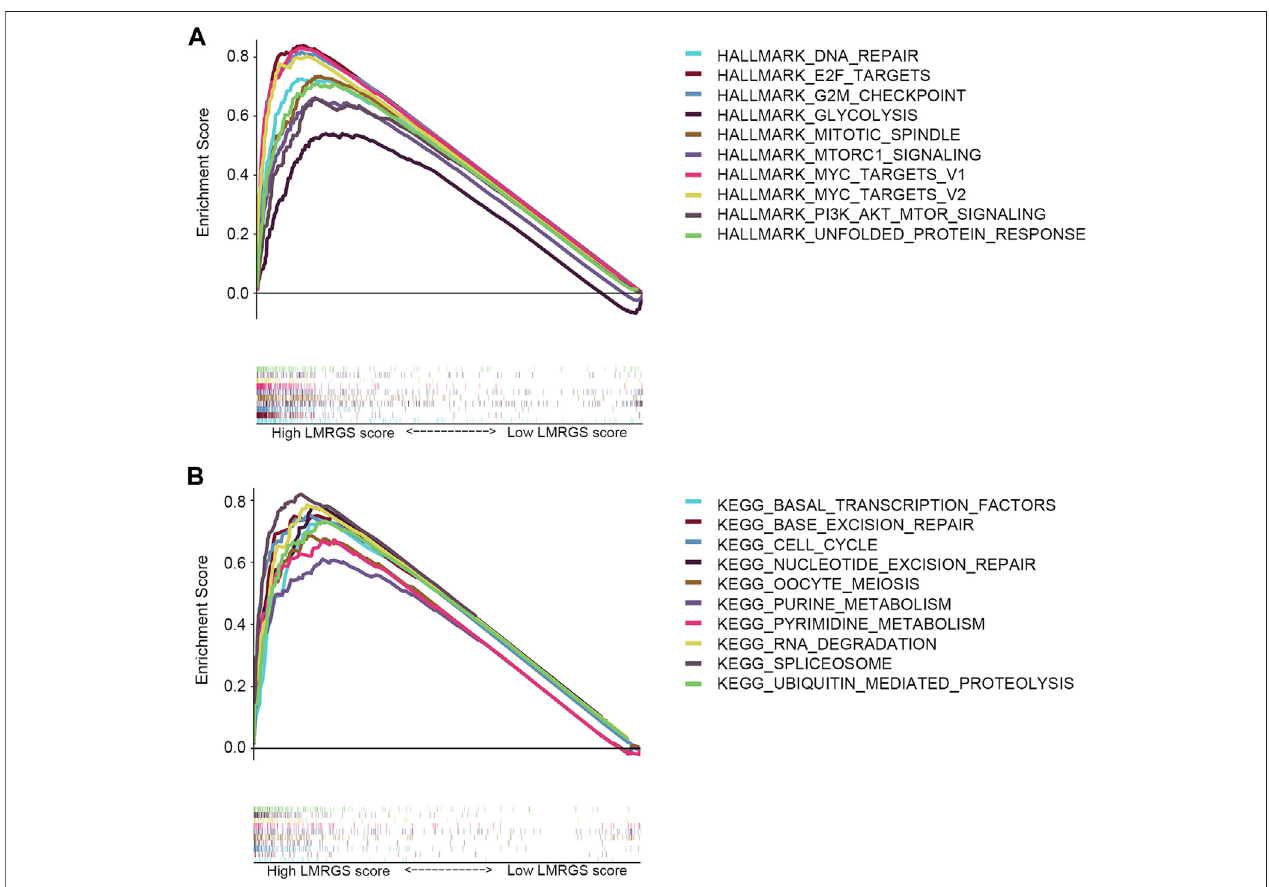
FIGURE 10 | GSEA of LMRGS-low and LMRGS-high groups. (A) Enrichment results of hallmark. (B) Enrichment results of signaling pathways.